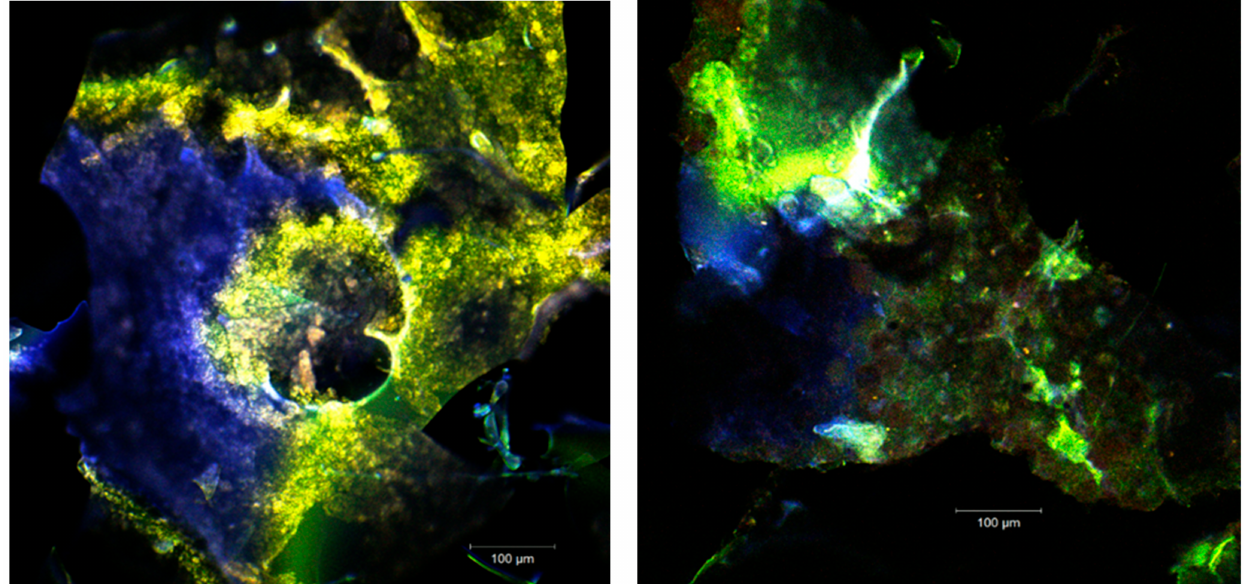
Figure 3. The confocal laser scanning microscopy (CLSM) images of the unstained native powders.